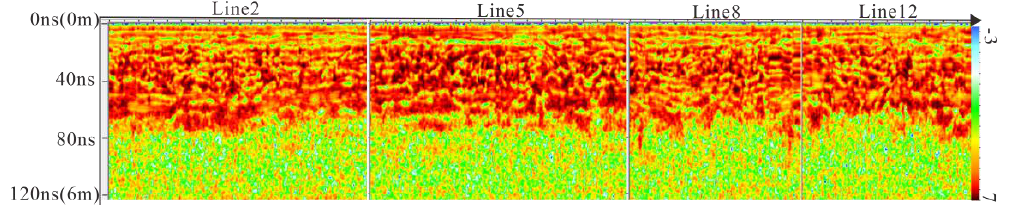
Figure 10. The weighted average frequency attribute.